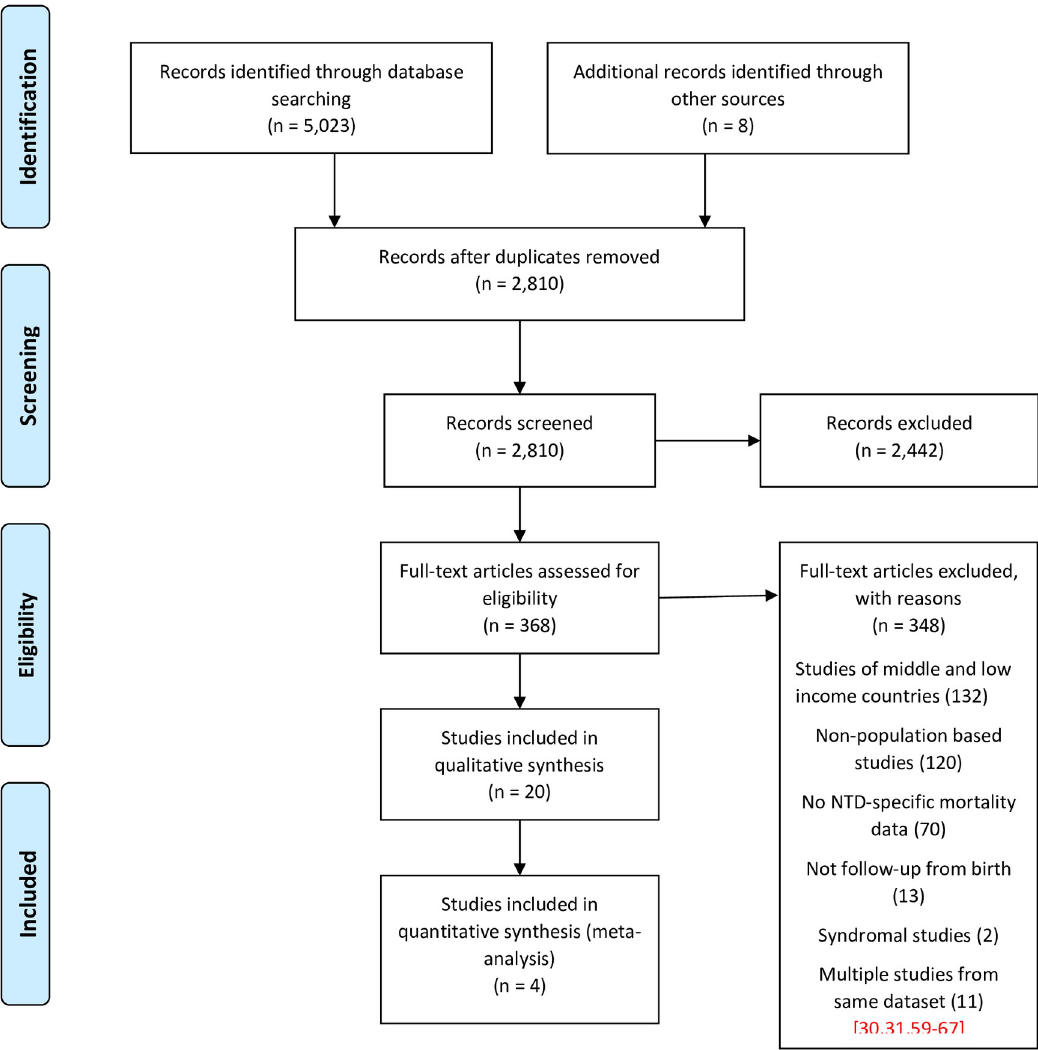
Fig 1. PRISMA diagram for the flow of articles through the review (1.1.1990 to 31.8.2020).